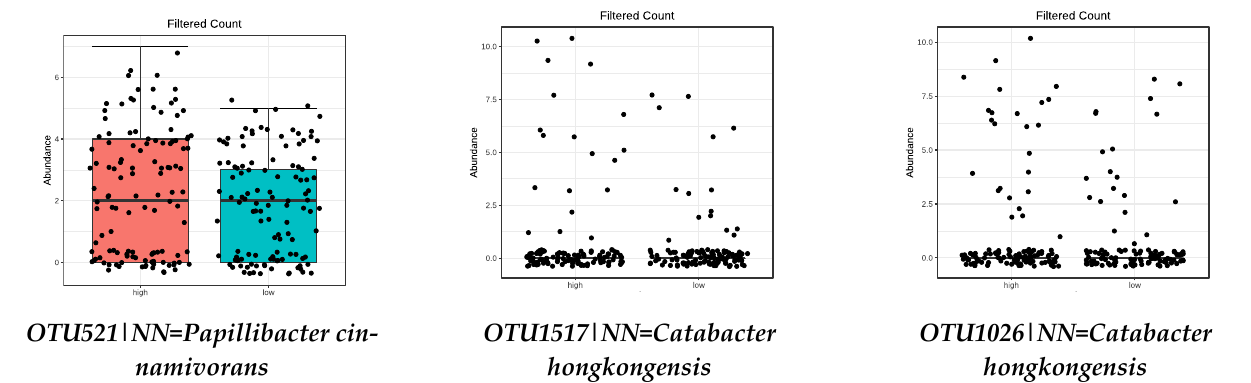
Figure 3. Bacterial species that were significantly more abundant in the group with high LEGUMES intake (FDR < 0.05) by metagenomeSeq test. Red boxes represent participants with a higher adherence to the MD and blue boxes low adher- ence.